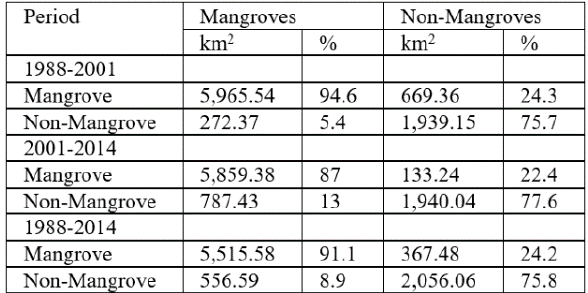
Table 3. Changes in the three past decades in